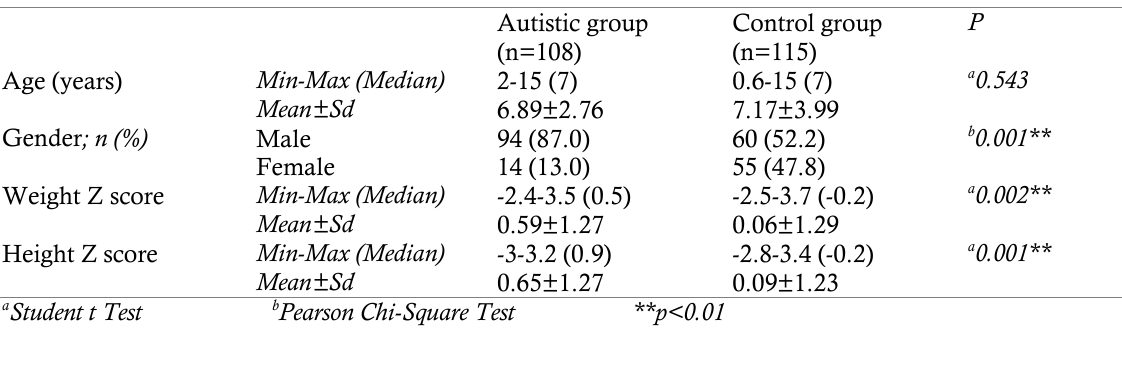
Table 4 . Evaluation of Descriptive Characteristics by